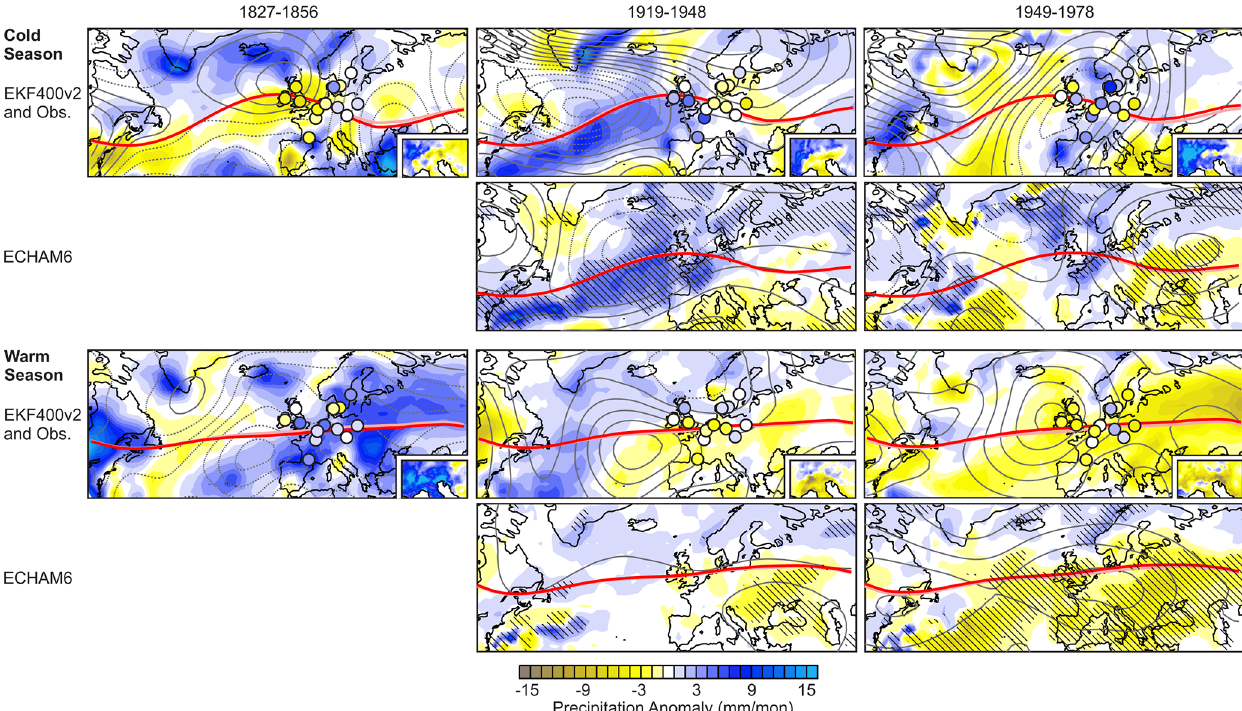
Figure 8. Simulated atmospheric circulation and precipitation. Anomalies (with respect to 1851–1950) of precipitation (colours) and 500hPa GPH (contour distance 2gpm centred around zero, dashed contours indicate negative numbers) in the 30-year periods 1827–1856, 1919– 1948, and 1949–1978 in the EKF400v2 reconstruction (ensemble mean), observations (insets: HISTALP; circles: GHCN), and ECHAM6 simulations. (Hatching denotes 95% significance of precipitation anomalies, calculated from the 30-year averages of the 31 members using a one-sample t test.) Thick red lines show the GPH contour 5450gpm (cold season) or 5650gpm (warm season; light pink lines: same for